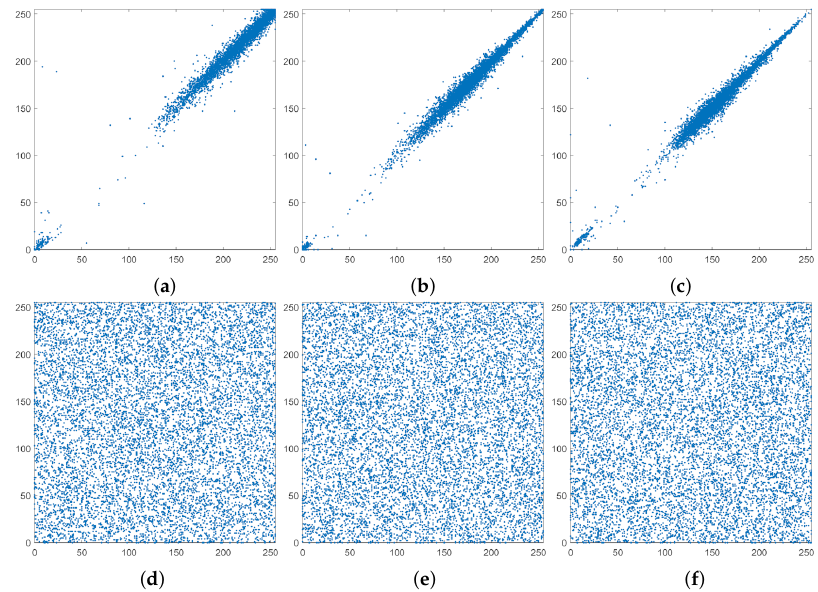
Figure 16. Correlation distributions of image number 6 (healthy patient). ( a ) Original image, red channel. ( b ) Original image, green channel. ( c ) Original image, blue channel. ( d ) Encrypted image, red channel. ( e ) Encrypted image, green channel. ( f ) Encrypted image, blue channel.